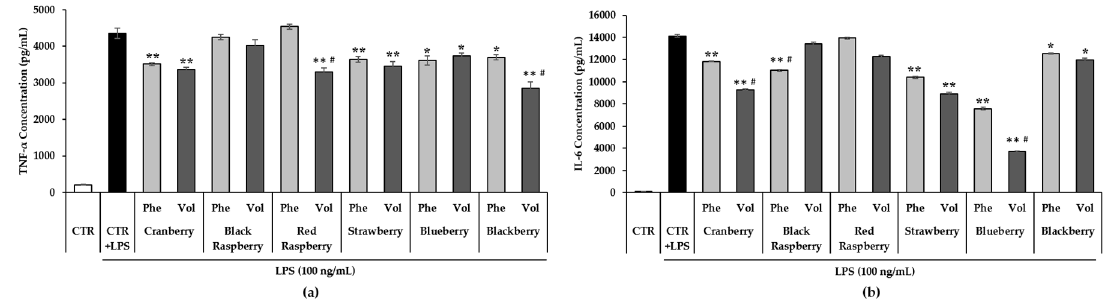
Figure 4. Effect of berry phenolic and volatile extracts (50-fold dilution) on ( a ) TNF- α and ( b ) IL-6 production. Data are expressed as the mean ± SEM ( n = 5). The significant difference was compared with the LPS-stimulated control at * p < 0.05, ** p < 0.01. # indicates a significant difference compared between phenolic and volatile treatment within each berry ( p < 0.05). CTR = control; Phe = phenolic extract; Vol = volatile extract.